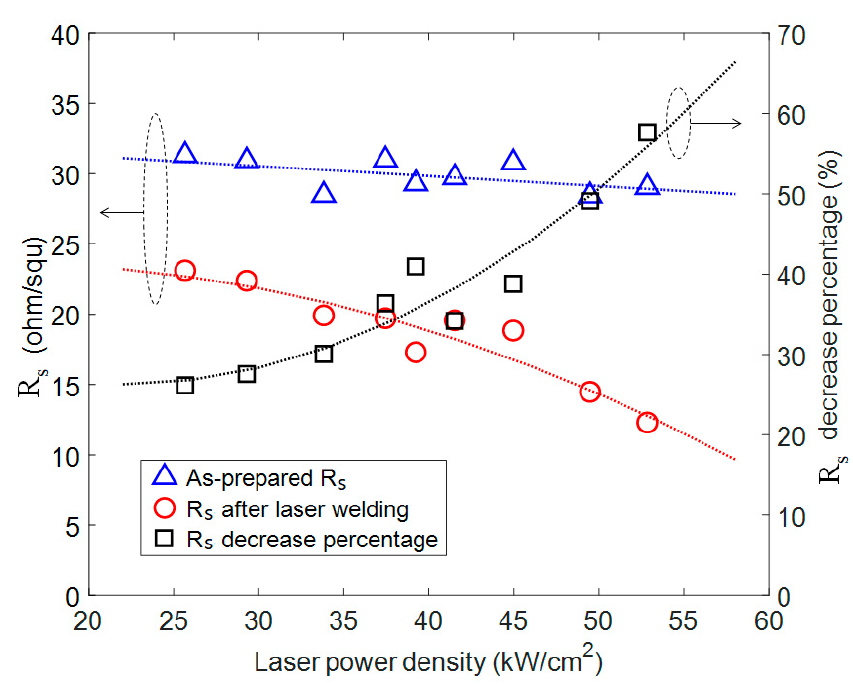
Figure 3. Sheet resistance change as function of laser power density. Blue triangles are the as-prepared R s and the red circles are the R s after laser welding of the same sample. The dark squares are the percentage decrease of R s of each sample. A fixed scan speed of 100 mm/s and a single time scan were used.